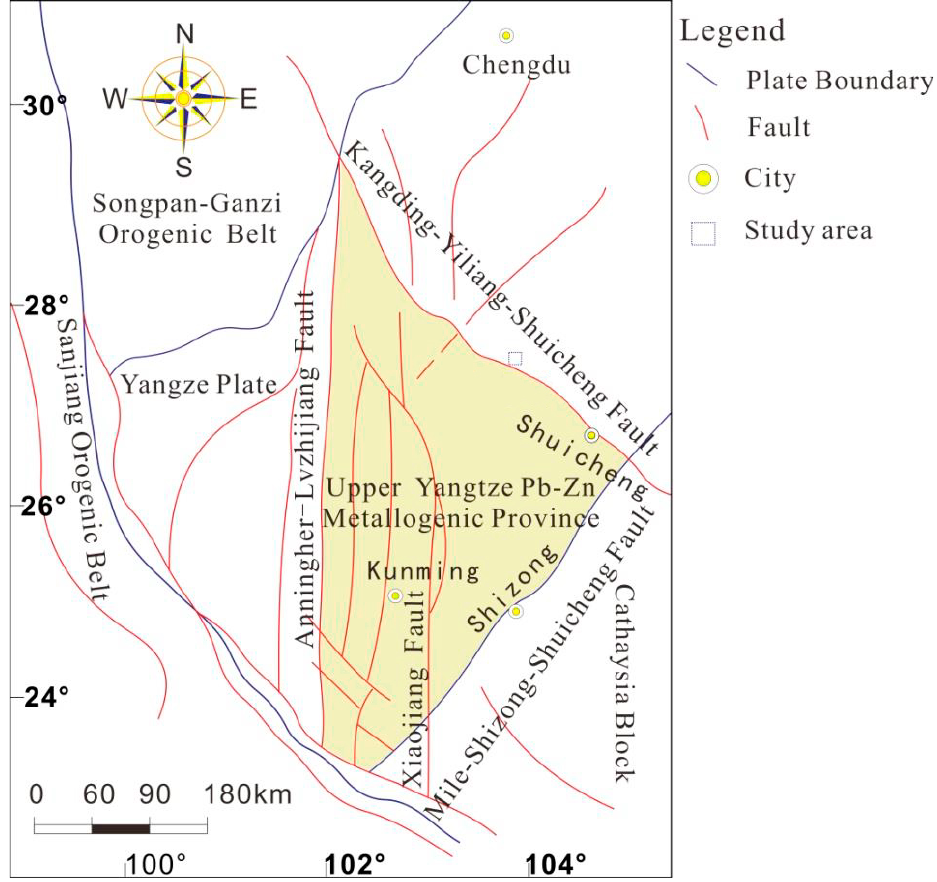
Figure 1. Regional geological map of the study area. Most of the outcrops observed in the area belong to the following groups: the Jurassic Shaximiao group (J 2 sx ), the Jurassic Suining group (J 2 s ), the Jurassic Ziliujing group (J 1 z ), Triassic Xujiahe group (T 2 x ), Triassic Guanling group (T 2 gl ), Triassic Jialingjiang group (T 1 j ), Permian Xuanwei group (P 2 x ), Permian Emeishan basalt (P e ), Permian Yangxin group (P 1 y ), Carboniferous longevity Wanshoushan group (C 1 w ), Devonian Zaijieshan group (D 3 zj ), Devonian Qujing group (D 2 q ), Devonian Suotoushan group (D 2 st ), Devonian Posongchong group (D 1 ps ), Silurian Caidiwan group (S 3 c ), Silurian Sifengya and Daluzhai group (S 2 s-d ), and Ordovician Daqing group (O 2 d ). The lithology mainly contains limestone, dolomite, basalt, sandstone, siltstone, mudstone, and siliceous rock (Figure 2). Dolomitization, calcilization, iron oxides/hydroxides, and silicification are the main types of alterations observed in the surrounding rock. The development of carbonation is prevalent in the mining area, which is mainly controlled by a fracture zone, joint fis- sures, and the surrounding rock. Dolomite and calcite recrystallization is obvious in the mineralized surrounding rock, forming coarse dolomite and calcite crystals, which are produced along the fissure in the form of veinlets and clusters. Iron oxides mainly occur in dolomite as disseminated, veined, and spotted dolomites are associated with galena and sphalerite. Silicification is mainly characterized by the development of quartz clusters in the dissolution cavity accompanied by Pb-Zn mineralization. Generally, the closer to the ore body, the larger the carbonate mineral crystallization, the more developed its aggregates or veinlets are; iron oxides/hydroxides tend to develop in the near-ore range and are obviously enhanced in the medium-coarse crystal dolomite with strong near-ore alteration. Typically, stronger alterations are seen in rocks the closer they are to the ore